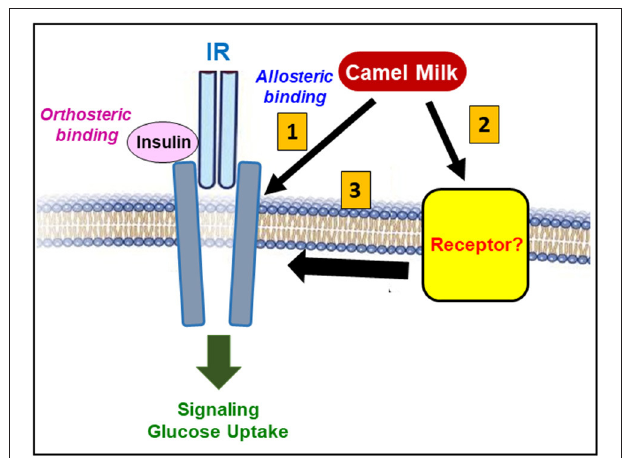
FIGURE 6 | Putative model highlighting IR targeting by CM. Overall, our recent studies on the effect of CM on IR demonstrates the positive action of CM proteins/peptides on IR activity and its downstream signaling pathways. At the molecular level, our data exclude the direct binding of CM proteins/peptides on the insulin’s binding site (orthosteric site) in IR. However, CM might plausibly activate IR either through an allosteric binding site leading to the positive modulation of IR and its related signaling pathways (1), or via a binding to another unknown receptor (2) that may synergistically/allosterically crosstalk or transactivates IR